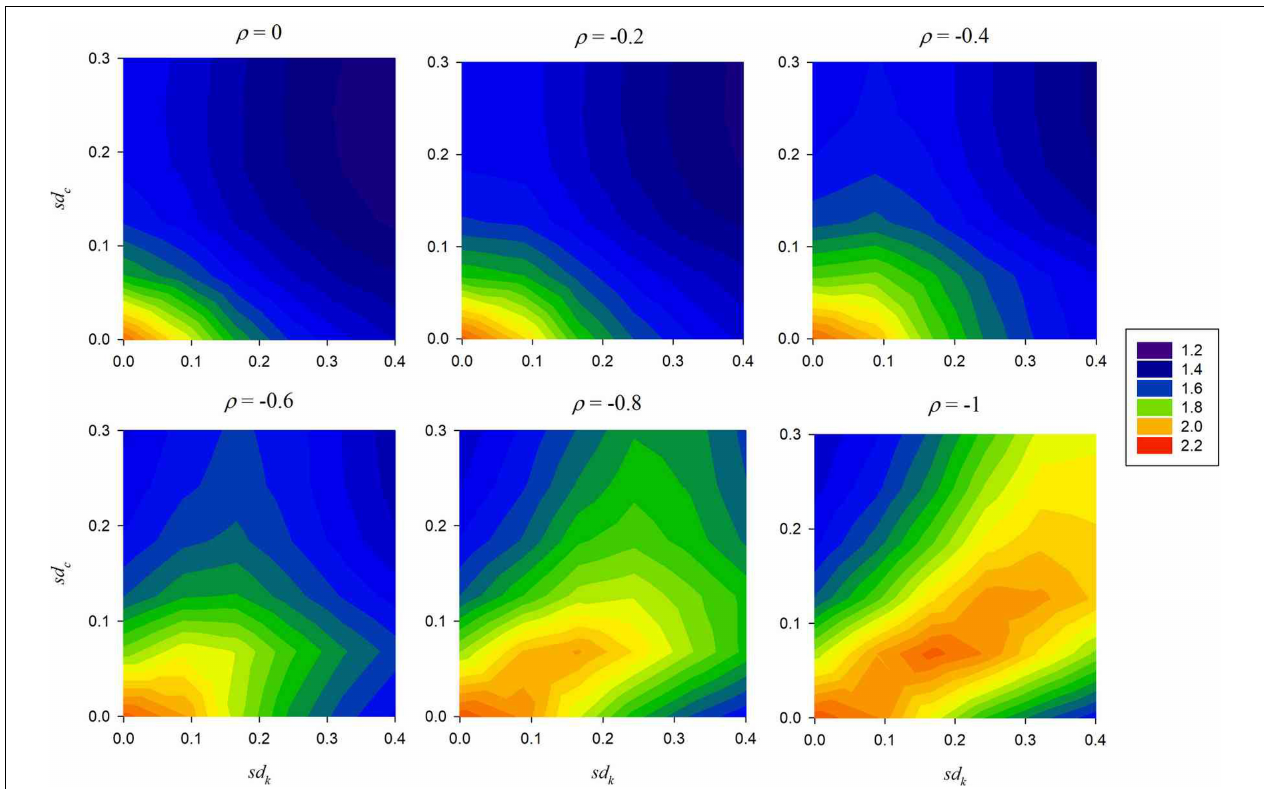
FIGURE 1 | Expected number of extant species ( nspp ), by colour, as a function of the variation in competition strengths ( sd k ) and the variation in the colonisation probabilities ( sd c ) for various levels of the correlation ρ between competition strength and colonisation probability. Number of land parcels N 2 = 115, number of species S = 5; other model parameters at the median values of their ranges (Table